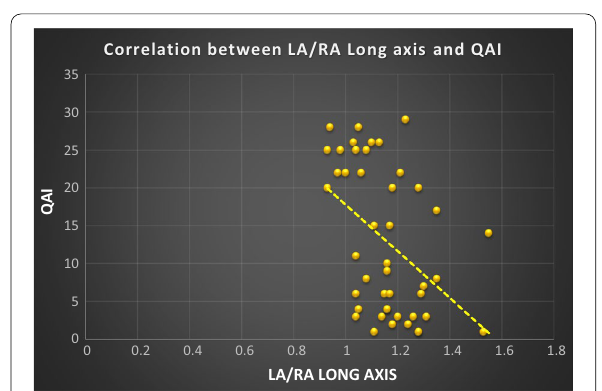
Fig. 3 Correlation Between LA/RA long axis and QAI